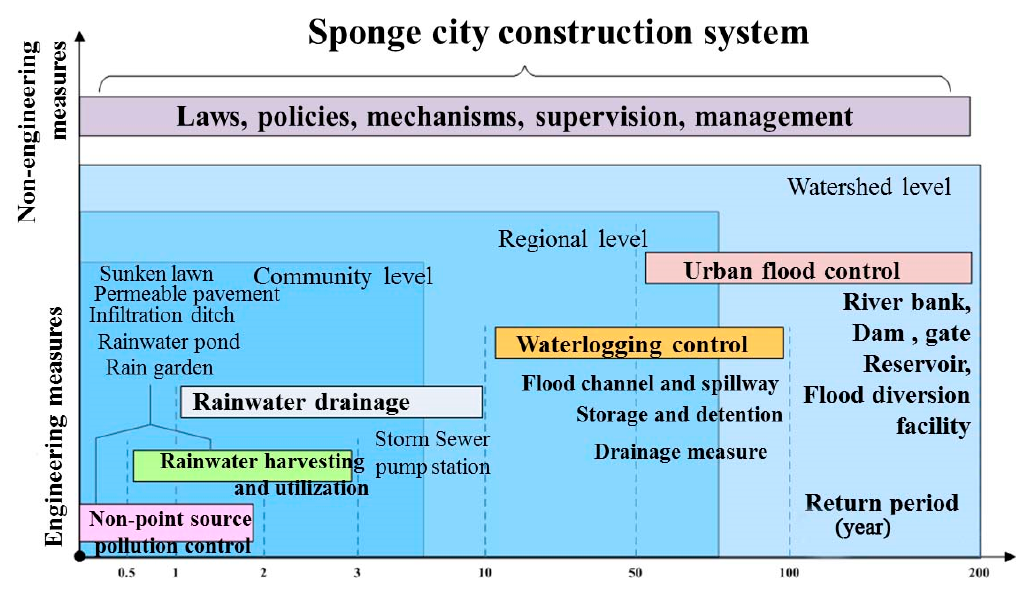
Figure 1. Diagram of sponge city construction system.